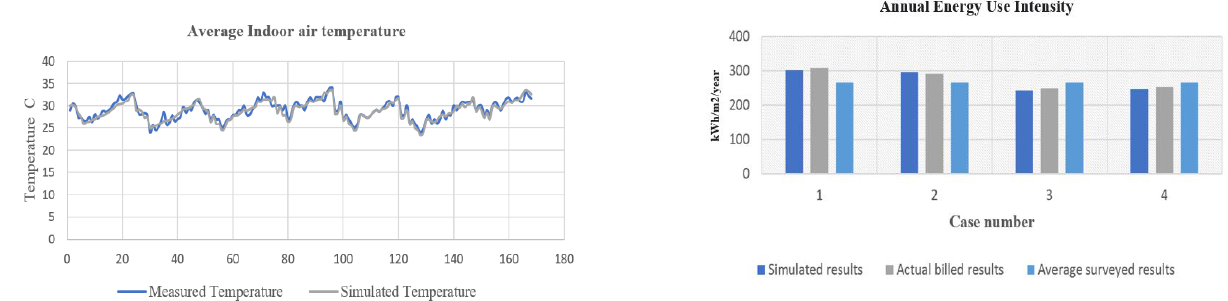
Figure 5. Validation of the calibration based on hourly and annual actual and simulated results.